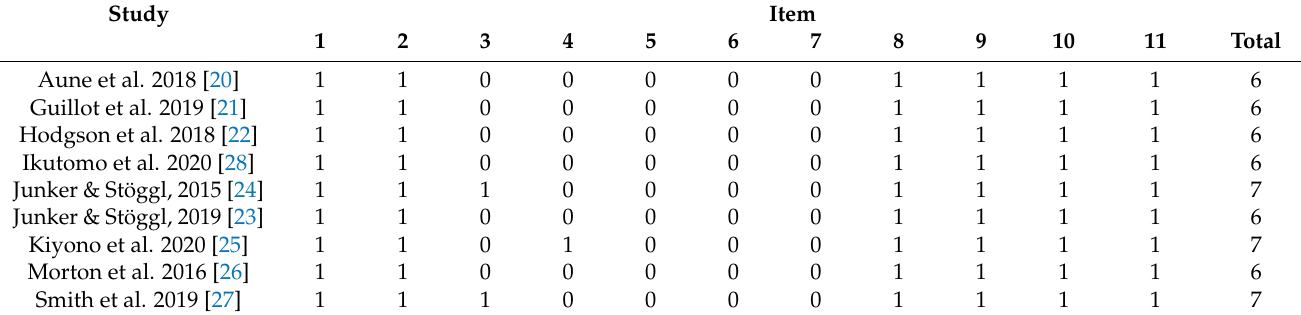
Table 1. PeDro Score of Studies Included in the Systematic